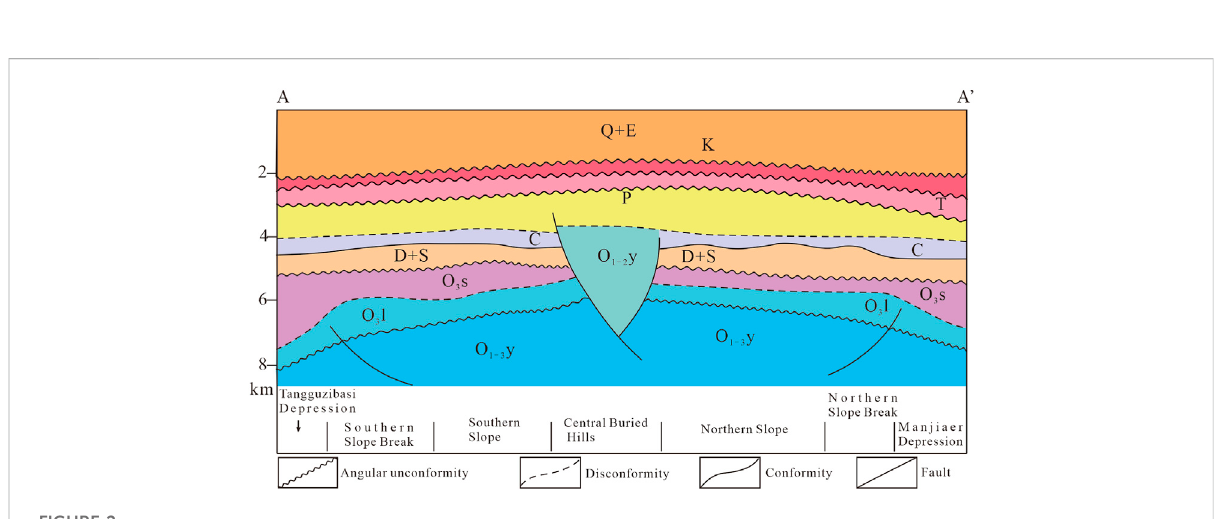
FIGURE 2 Schematic diagram of geological cross-section of the Tazhong Uplift in the southwest-to-northeast